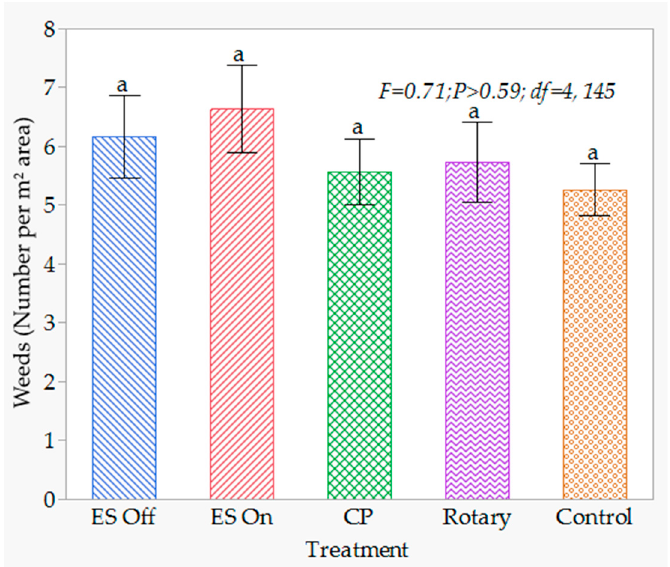
Figure 2. Number of weeds (broadleaf and grassy weeds) per m 2 in the test area during year two of the study. Treatments shown on the X -axis are electrostatically charged off (ES Off) and charged on (ES On) nozzles, the conventional hydraulic (CP) nozzle, and the rotary atomizer (Rotary) nozzle, and the untreated control. Means (±SEM) followed by the same lowercase letters are not significantly different.